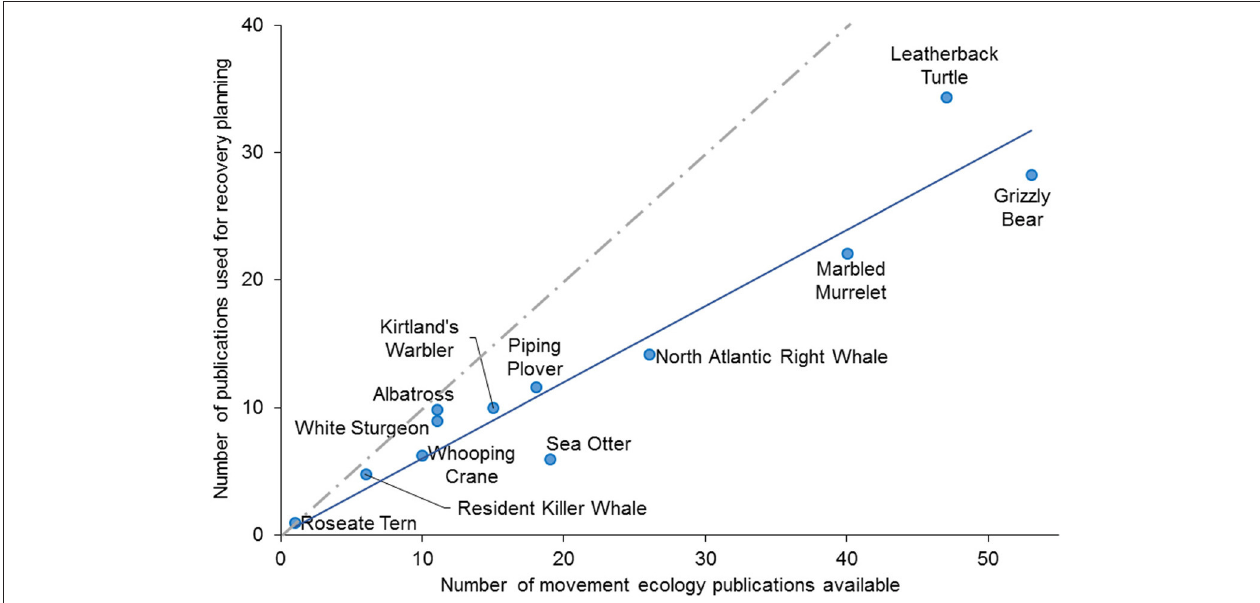
FIGURE 2 | Conservation status assessments and recovery planning for threatened species are informed by only a proportion of the available research on movement ecology. Availability (y-axis) and use (x-axis) of research on movement ecology are strongly correlated (best-fit line, slope = 0.6, r 2 = 0.91, p < 0.001) but recovery planning for 11/12 species did not use all available data. Gray dashed line shows a 1:1 correlation for comparison. Figure includes all species occurring in the United States and Canada that have trans-jurisdictional ranges, for which conservation status assessments and recovery plans have been completed, and that have